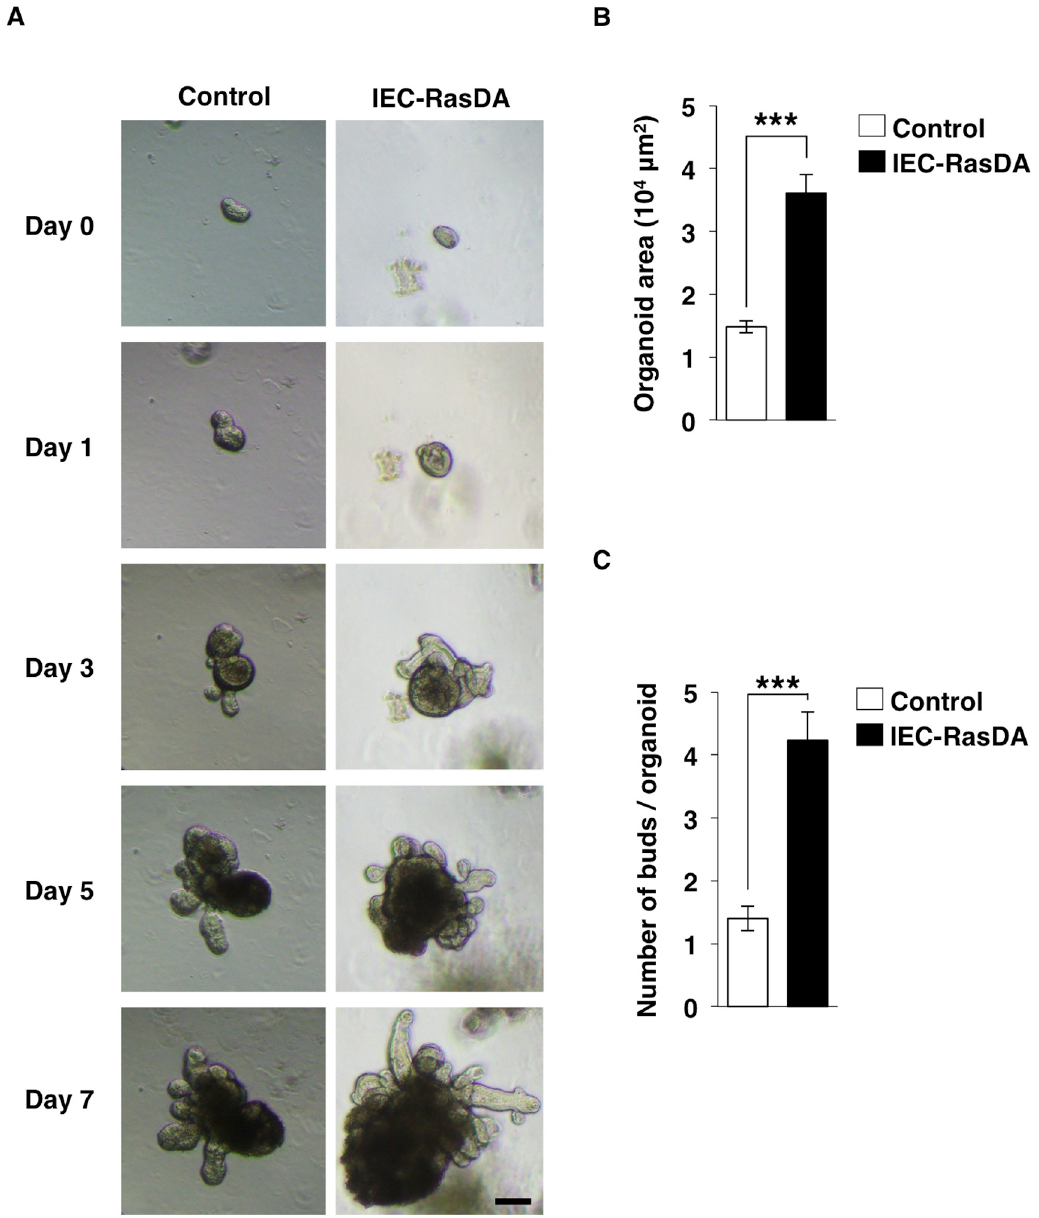
Fig 3. Promotion of the development of intestinal organoids by K-Ras activation. ( A ) Images of intestinal organoids derived from the ileum of 12-week-old control or IEC-RasDA mice at the indicated times after cell plating. Scale bar, 100 μ m. ( B ) Areas of intestinal organoids at 3 days after cell plating. ( C ) The number of buds per intestinal organoid at 3 days after cell plating. Data are means ± s.e. for a total of 30 organoids from control or IEC-RasDA mice at 12-week-old. ��� P < 0.001 (Student’s t test).